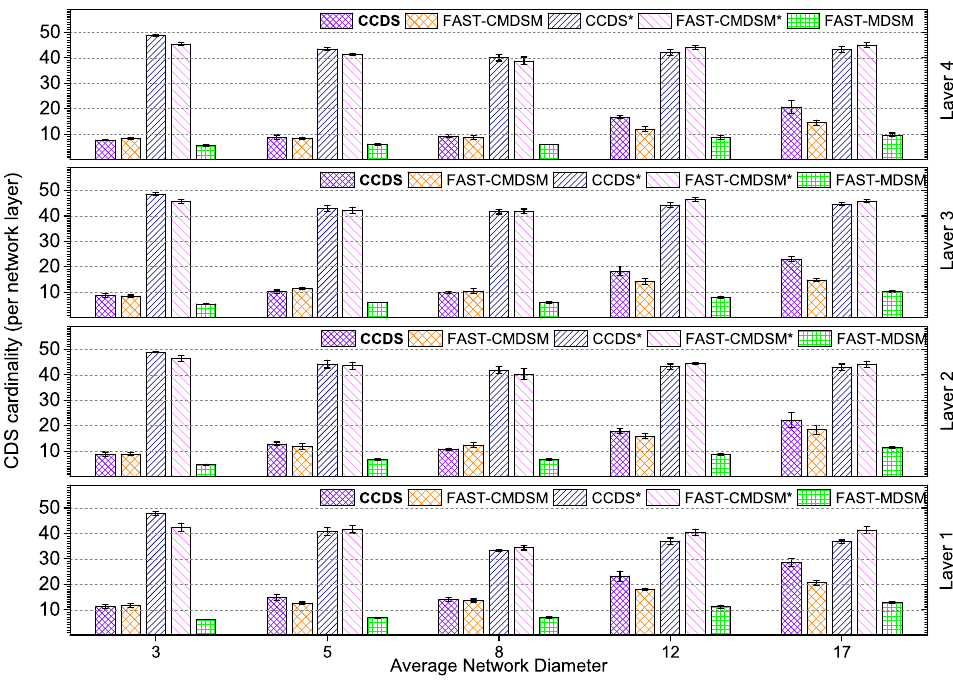
Figure 8. Impact of network diameter (High skewness).